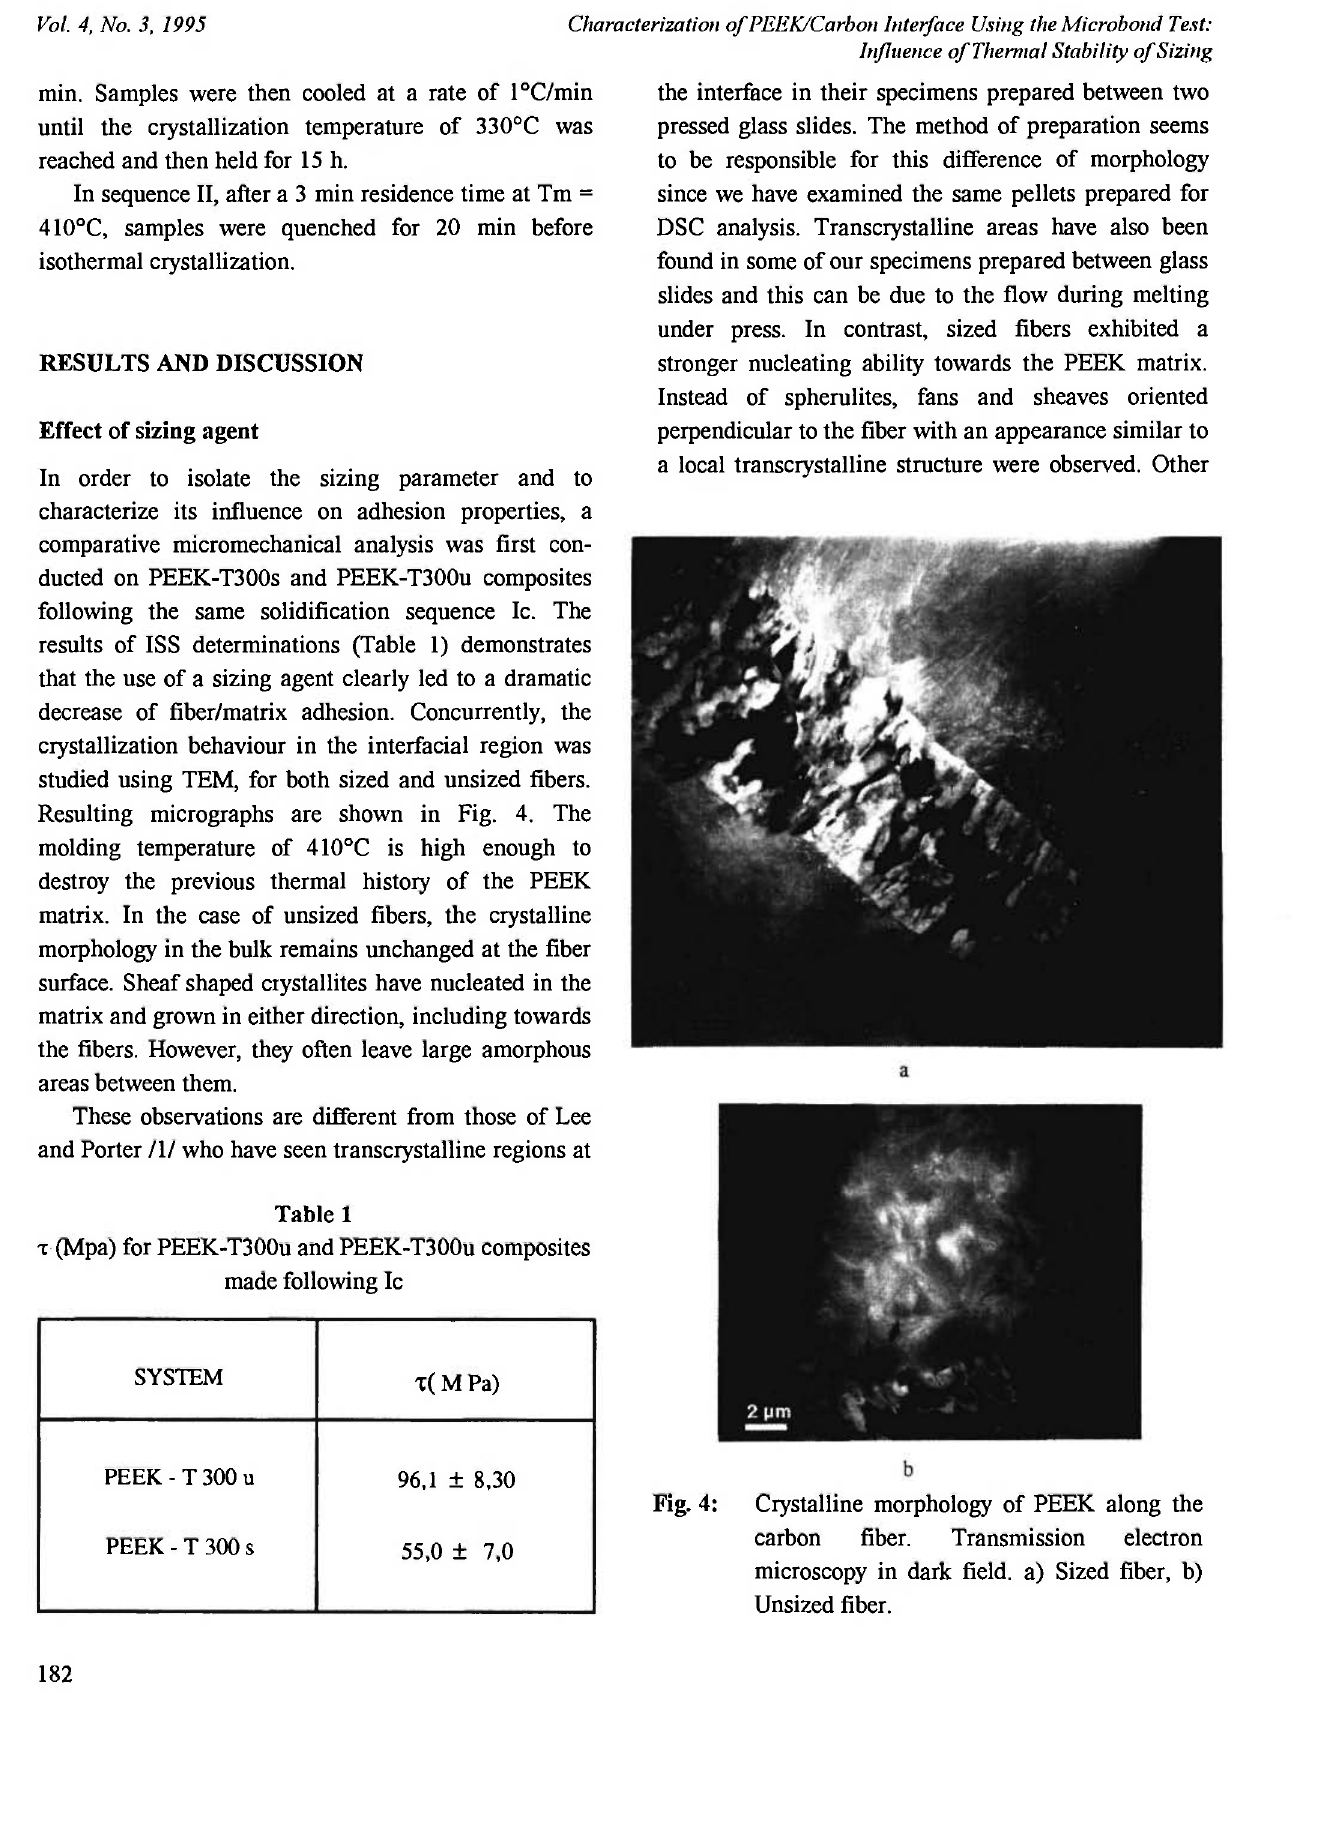
Fig. 4: Crystalline morphology of PEEK along the carbon fiber. Transmission electron microscopy in dark field, a) Sized fiber, b) Unsized